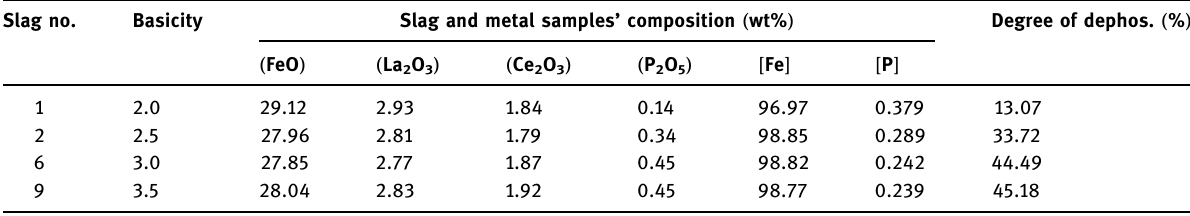
Table 3: Chemical composition of slags and metal after dephosphorization experiments at 1,550°C ( wt% ) Slag no.